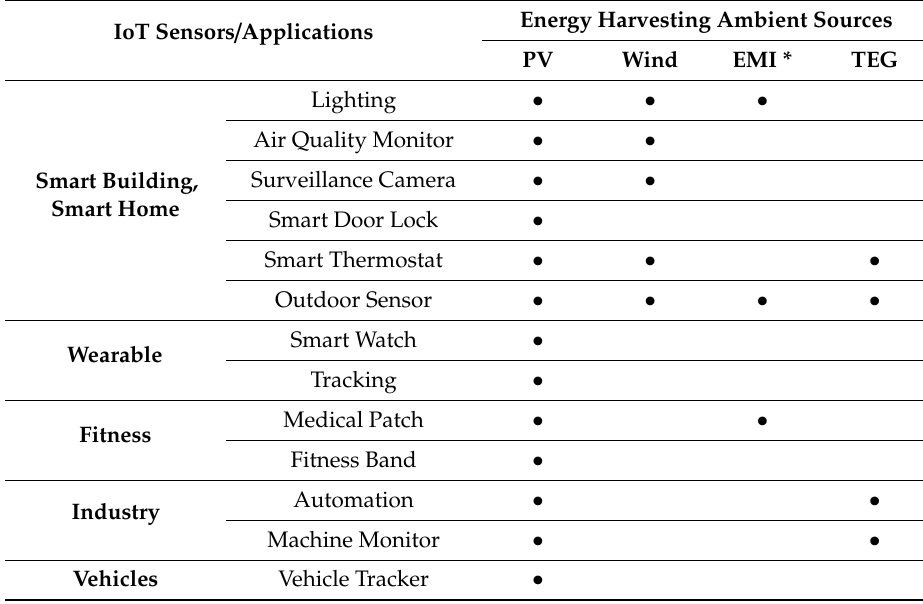
Table 3. IoT applications and the di ff erent EH systems (EHSs)